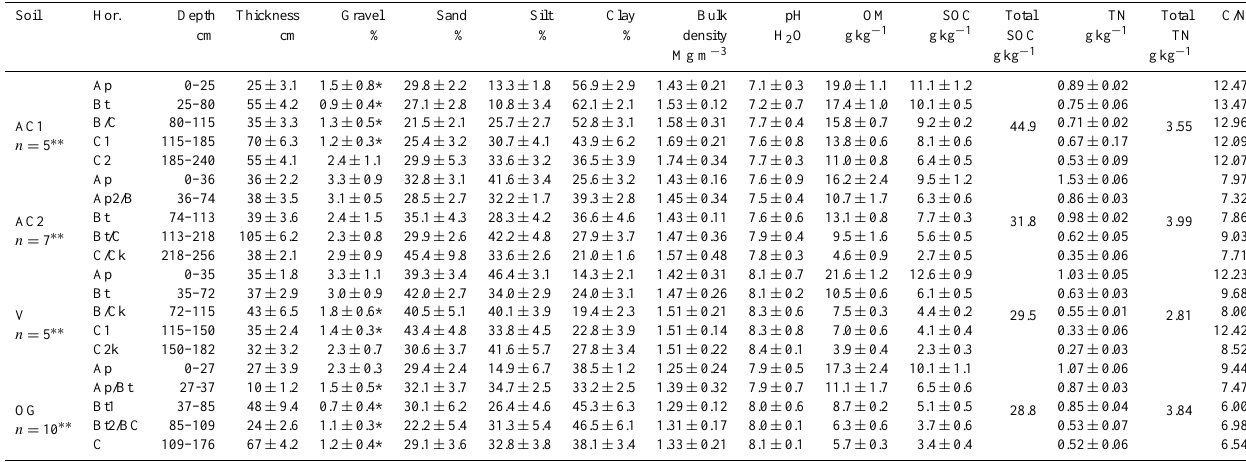
Table 2. Basic physical and chemical properties for Calcic/Chromic Luvisol in Arable land (wheat and barley annual rotation), Vineyard and Olive groves. AC1: Arable crop 1965, AC2: Arable crop 2006, V: Vineyard 2006, OG: Olive groves 2006. Data are means ± SD ( n = 5, 7, 5, 10). Hor. = Horizon type. Soil